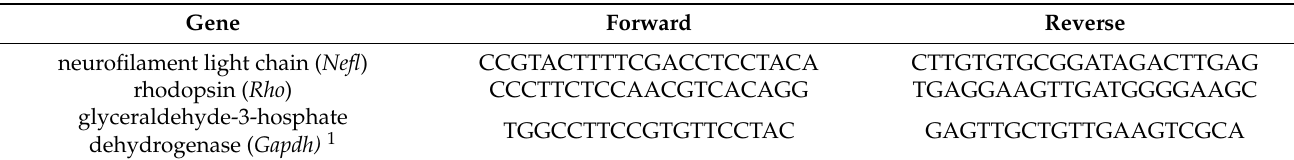
Table 1. Primer sequences used in the quantitative PCR study in 5 (cid:48) to 3 (cid:48) direction. Gene Forward Reverse neurofilament light chain ( Nefl ) CCGTACTTTTCGACCTCCTACA CTTGTGTGCGGATAGACTTGAG rhodopsin ( Rho ) CCCTTCTCCAACGTCACAGG TGAGGAAGTTGATGGGGAAGC